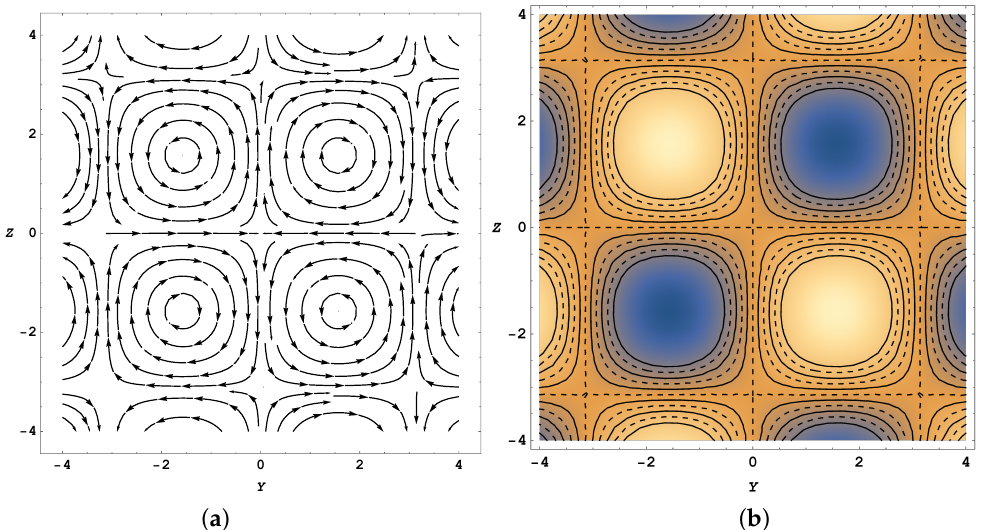
Figure 2. Fragments of ( a ) the velocity field as per Equation (38), and ( b ) the density of vorticity field as per Equation